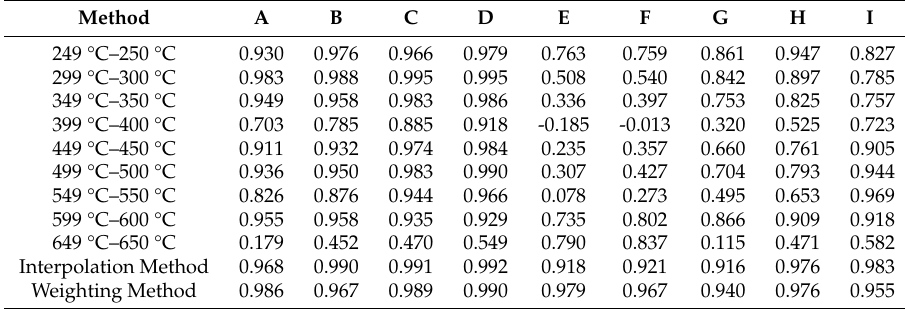
Table 6. A summary of coefficients of determination ( R 2 ) for the test temperatures profiles, fitted using the three Green’s function implementation methods.